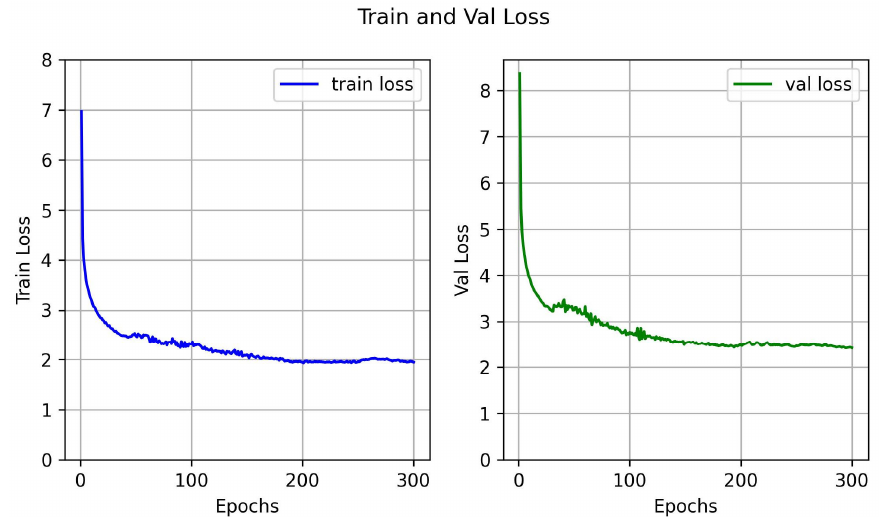
Figure 7. Training loss and validation loss of our model on the UIEB dataset .